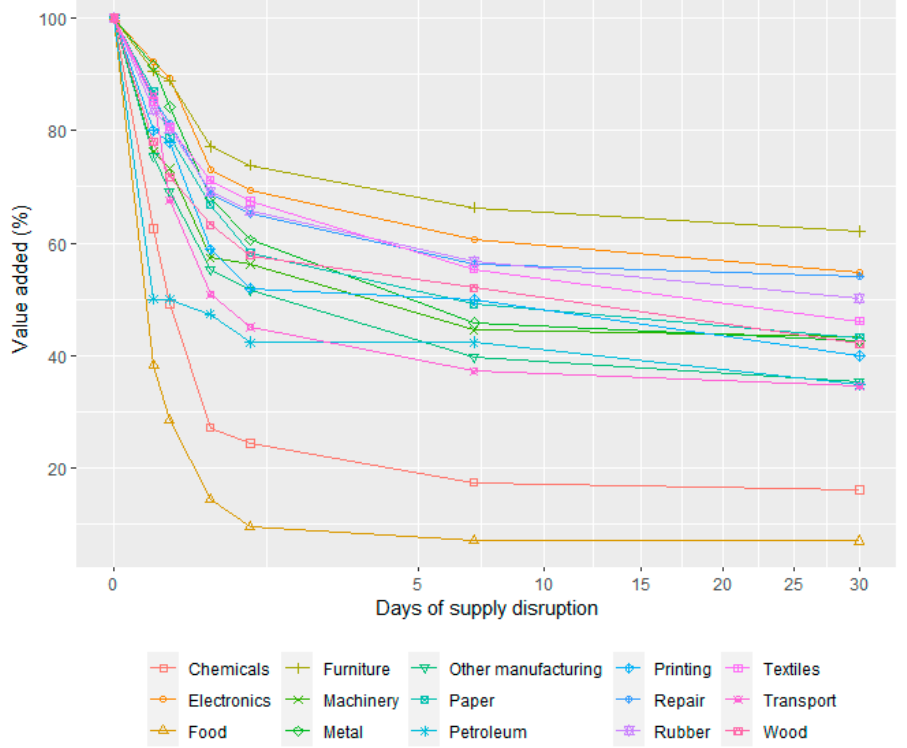
Figure 4. Maintained value added in the manufacturing sector, expressed as a percentage of normal business activity during water supply disruptions of different durations.